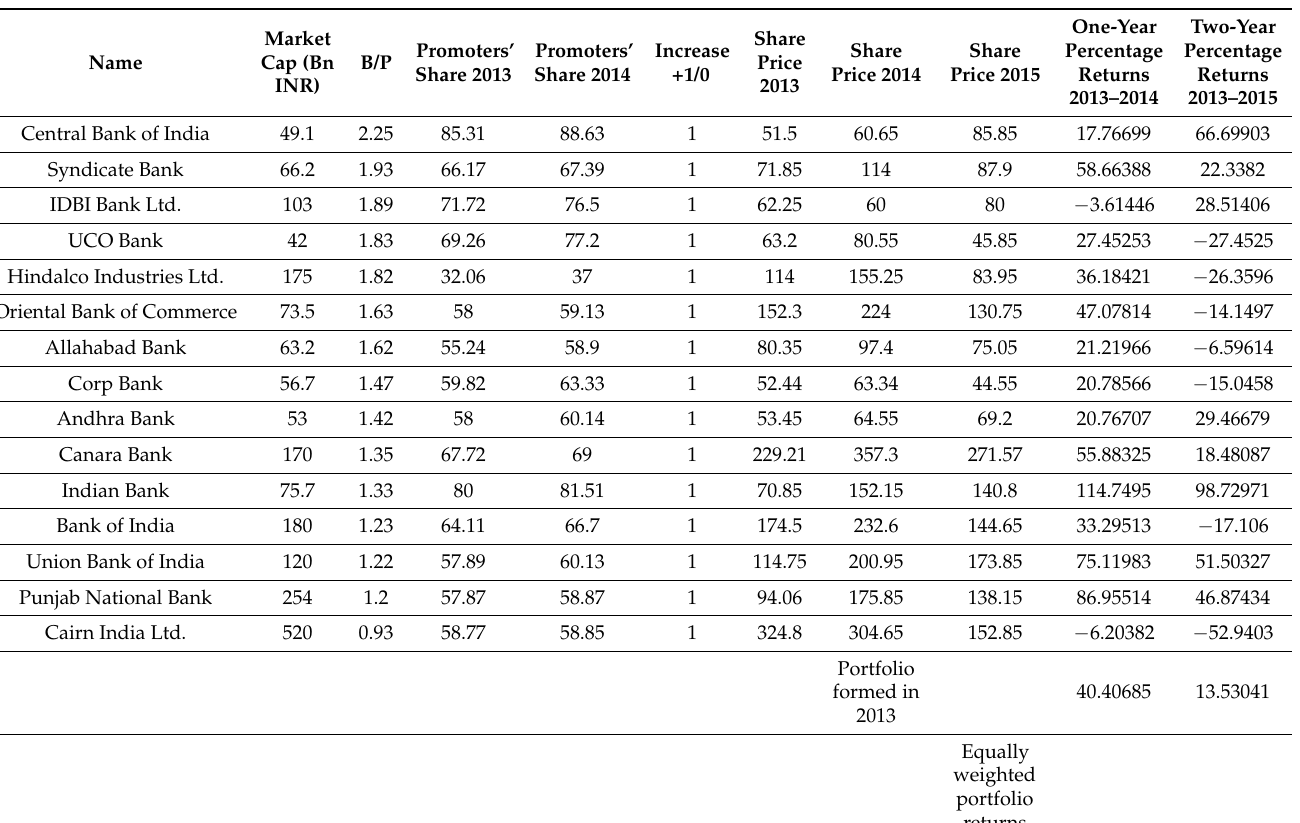
Table 3. Portfolio 2013 (financial details of small-cap companies whose promoter holdings increased in a year).